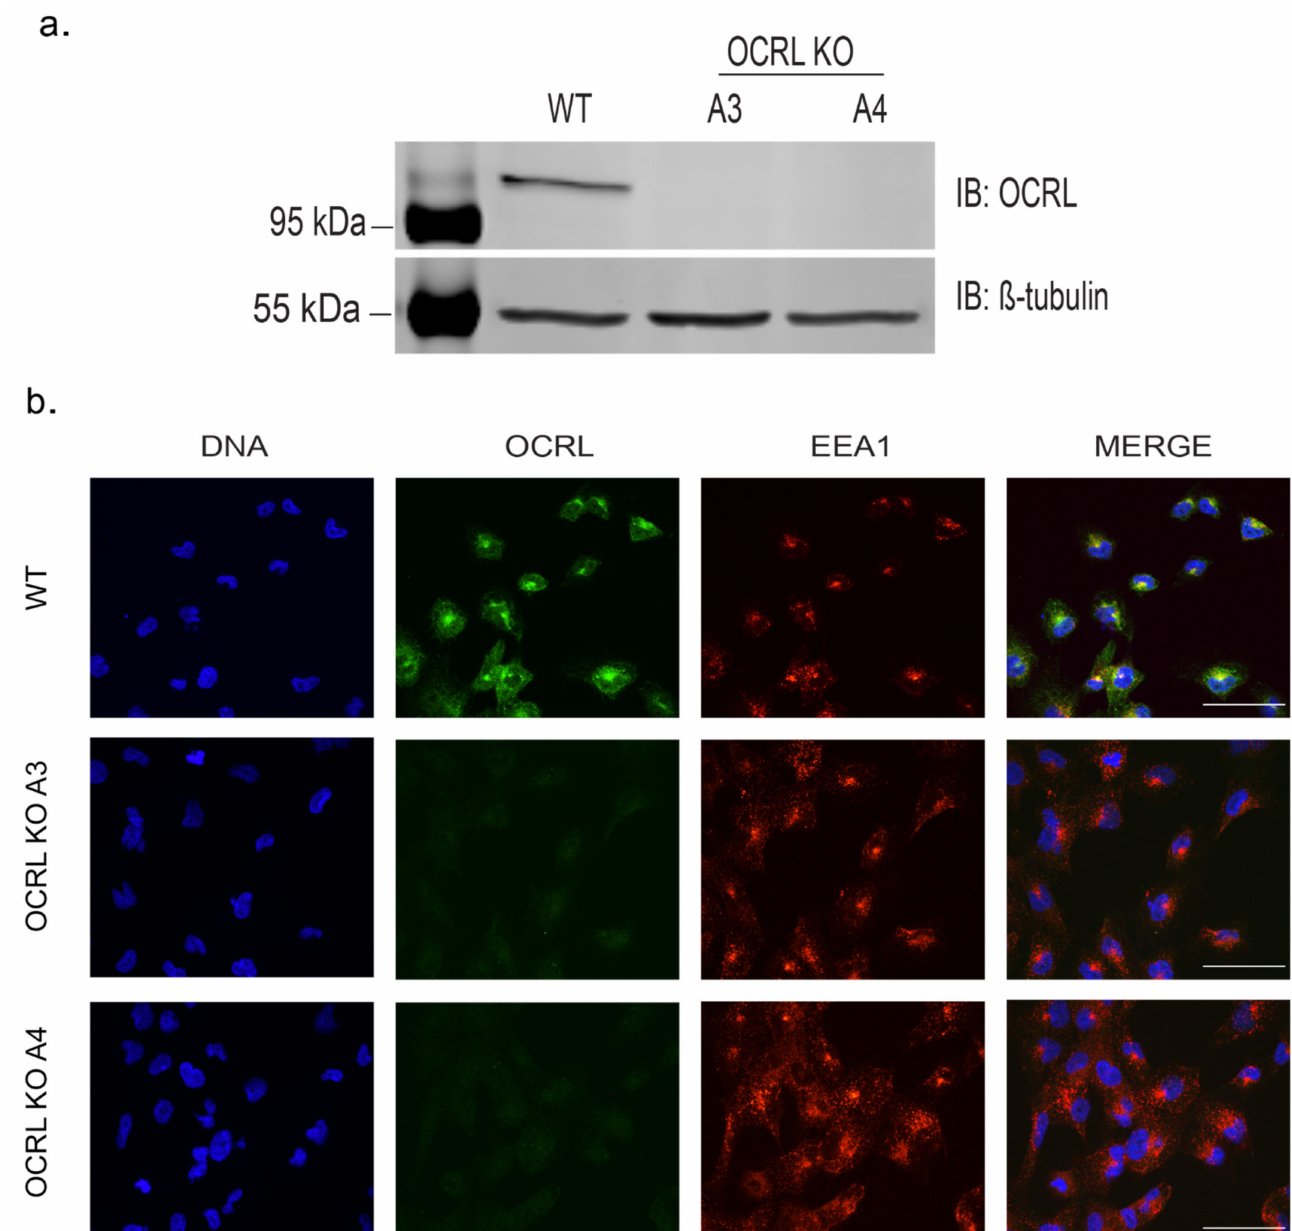
Figure 1. Confirmation of OCRL KO stable cell lines: ( a ) Western blotting with Anti-OCRL–No OCRL protein was detected in A3 or A4, but WT shows the band at the predicted size of 110 kDa. Anti- β tubulin at 55 kDa was used as a loading control. ( b ) Immunostaining of WT and KO clones with Anti-OCRL and EEA1 (early endosomes) showing no punctate staining for OCRL in KO clones (A3 and A4). Images were taken by Airyscan confocal microscope, scale bars: 20 µ